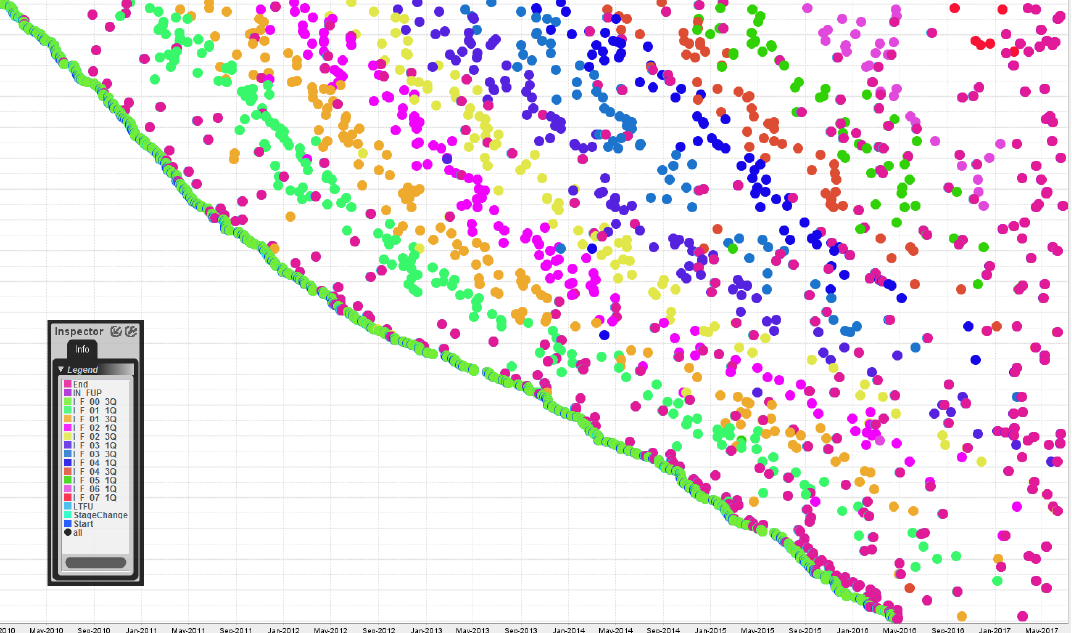
Figure 6. Dotted Chart Analysis of the stage I event log. The x-axis shows the timestamps of the events. The y-axis lists all cases sorted by the timestamps of their start event, descending. The dots represent the events, color-coded based on event label according to the legend on the